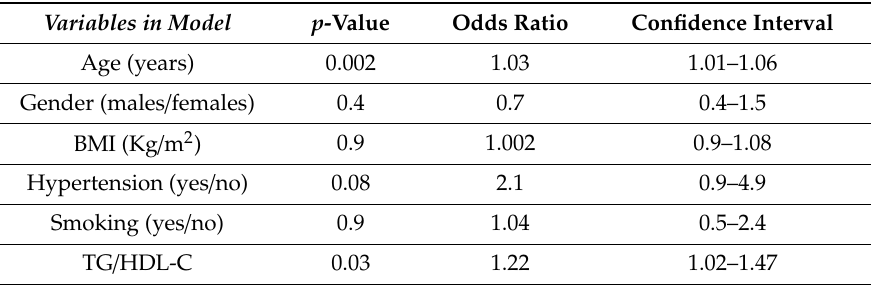
Table 5. Logistic regression analysis for the prediction of UACR > 30 mg / gr. Variables in Model p -Value Odds Ratio Confidence Interval